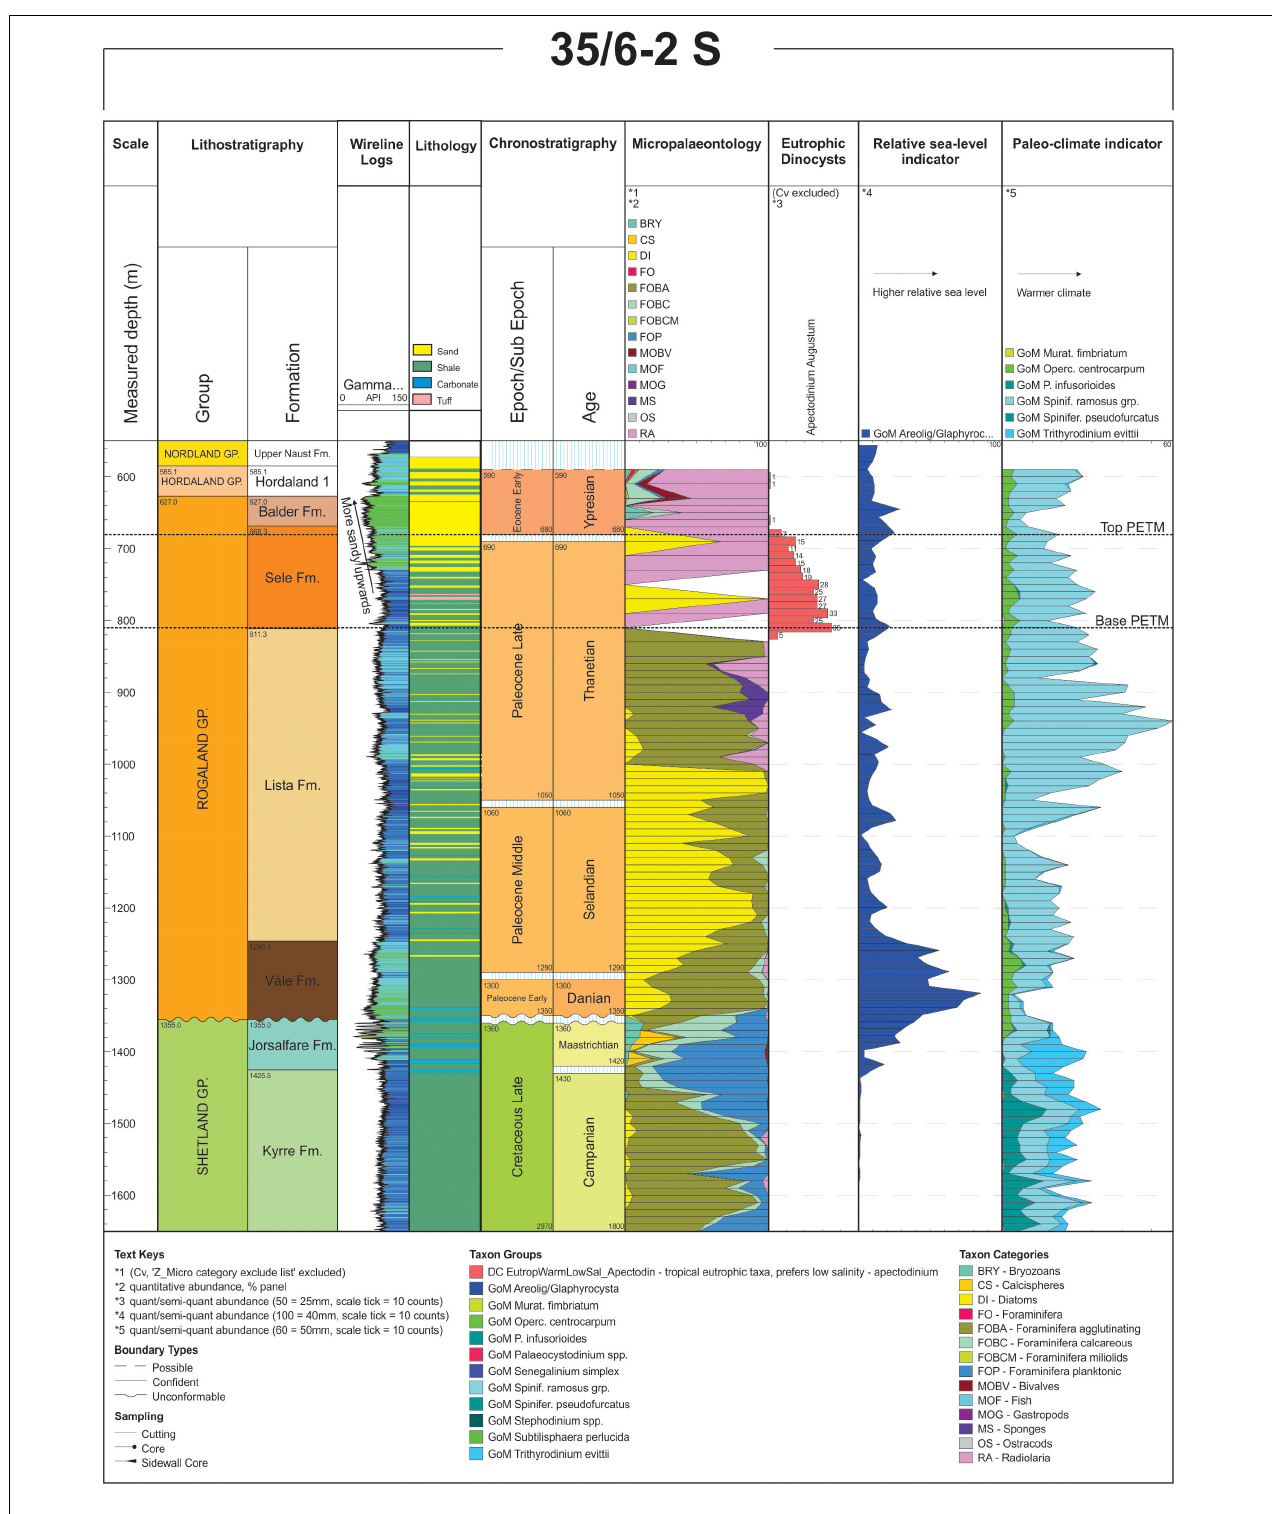
FIGURE 6 | Biostratigraphic information for borehole 35/6-2S. The PETM is defined in micropaleontological data by the extinction of benthic fauna and in dinoflagellates by the presence of A. Augustum between ∼ 680 and ∼ 810 m. Peaks in Areoligera/Glaphyrocysta and Spiniferites ramosus grp. are considered indicators of relative sea-level and climate variability, respectively. The data indicate relative sea-level rise at the base of the Paleocene succession and within the Balder Fm. Increasing relative sea-level toward the top of the Balder Fm is also indicated by more shale-dominated lithologies and an increase in gamma ray in the wireline log. High gamma ray and blue colors are indicative of shale-dominated lithologies whereas low gamma and green colors are indicative of sand and carbonate dominated lithologies.